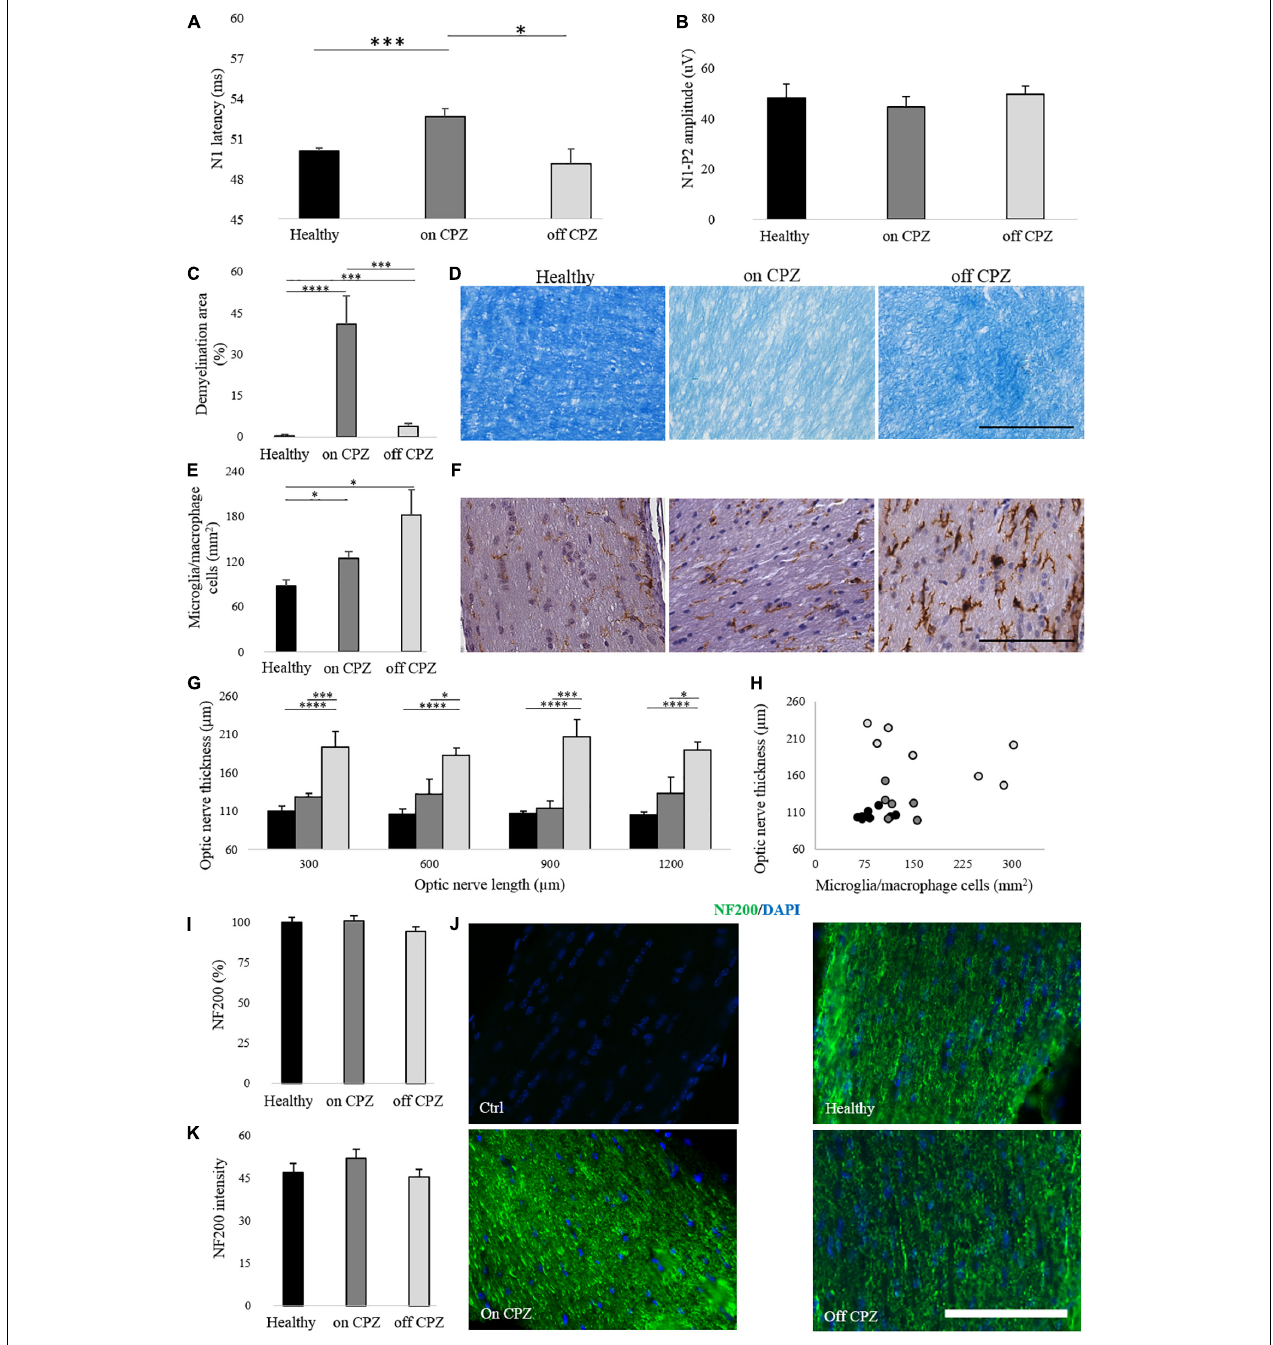
FIGURE 4 | Visual evoked potentials and optic nerve histology on and off CPZ diet. (A,B) N1 latency and N1-P2 amplitude on CPZ and off CPZ diet. Black bars represent healthy ( n = 16 eyes), dark gray bars represent mice on the CPZ diet ( n = 16 eyes), light gray bars represent mice off the CPZ diet ( n = 16 eyes). (C) Quantification of demyelination area (%) in optic nerves stained with LFB. (D) Representative optic nerve images stained with LFB. (E) Quantification of microglia/macrophage cells (mm 2 ) in optic nerves stained with Iba 1. (F) Representative optic nerve images stained with Iba1 + . (G) Quantification of optic nerve thickness ( µ m). (H) Correlation between microglia/macrophage cells (mm 2 ) and optic nerve thickness ( µ m). (I) Quantification of NF200 (%) in optic nerve stained with NF200/DAPI. (J) Representative optic nerve images stained with NF200/DAPI for control of the staining and each group. (K) Quantification of NF200 signals intensity. Black bars/dots represent Healthy ( n = 8 optic nerves), dark gray bars/dots represent mice on the CPZ diet ( n = 7 optic nerves), light gray bars/dots represent mice off the CPZ diet ( n = 7 optic nerves). (D,F) Images acquired by microscope in white field 40 × of magnification (scale bar, 100 µ m). (J) Images acquired by fluorescence microscopy at 40 × of magnification (scale bar, 100 µ m). (A–C,E,I,K) T-student between groups. (G) Two-way ANOVA followed by LSD post hoc * p < 0.05; ** p < 0.01; *** p < 0.001 and **** p < 0.0001.